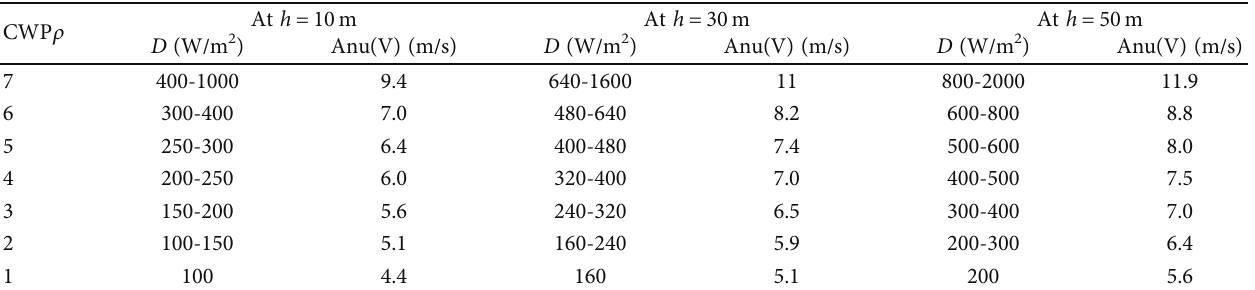
Table 4: Wind power density and wind speed at di ff erent heights at h = 10 m , h = 30m , and h = 50 m ; CWP ρ : classi fi cation of wind power density, D (W/m 2 ), annual wind speed, and Anu(V) (m/s).